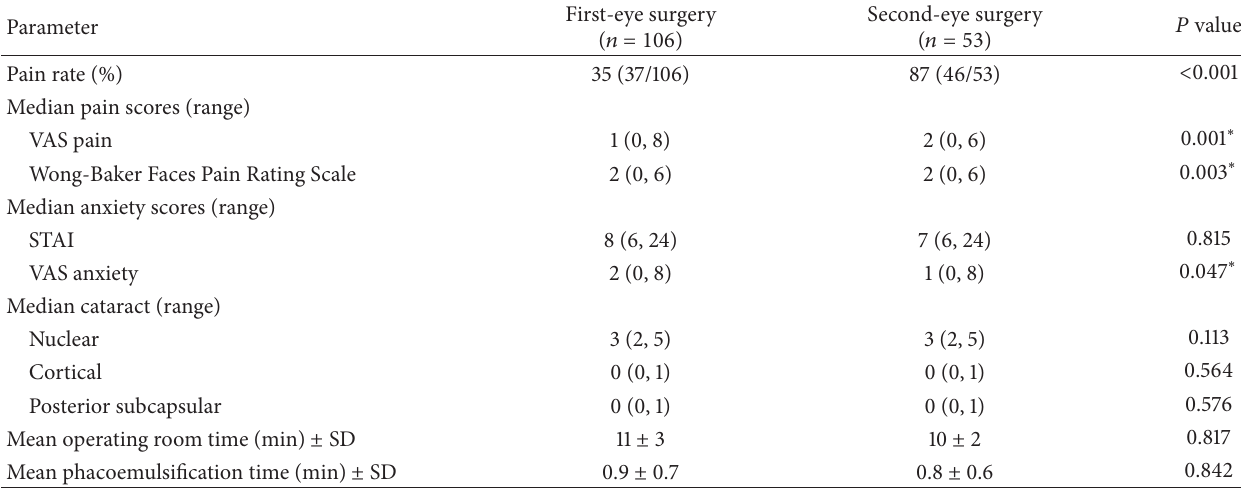
Table 2: Differences between first- and second-eye cataract